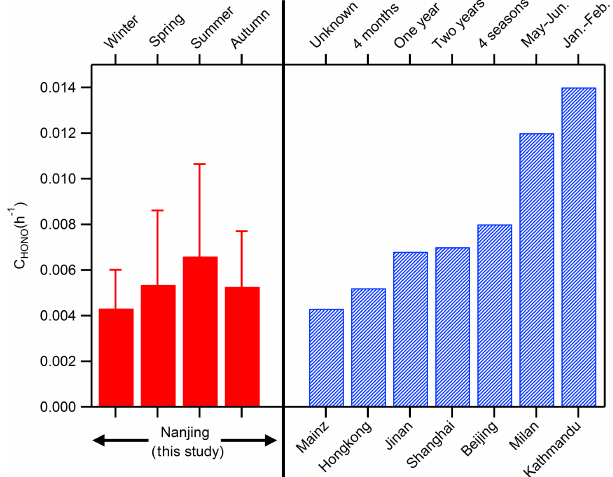
Figure 5. Comparison of observed NO 2 -to-HONO conversion rates in cities: Nanjing (this study); Mainz (Lammel, 1999); Hongkong (Xu et al., 2015); Jinan (Li et al., 2018); Shanghai (Wang et al., 2013); Beijing (Wang et al., 2017); Milan (Alicke et al., 2002); and Kathmandu (Yu et al., 2009).